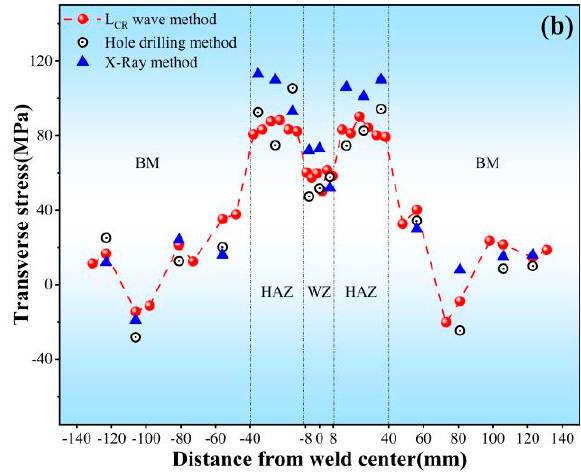
Figure 7. Comparison of ultrasonic correction test method with other test methods. ( a ) Longitudinal residual stress. ( b ) Transverse residual stress.